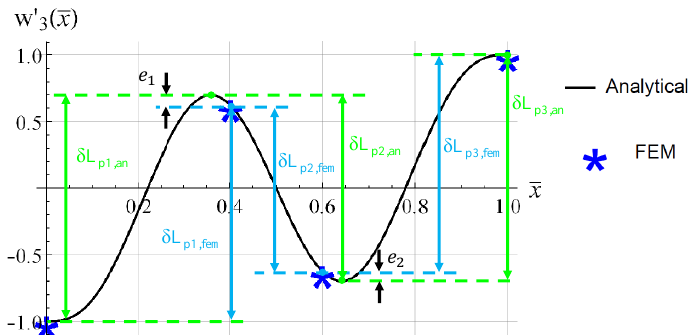
Figure 6. Example of discretization errors when evaluating the damping effectiveness in the case of free-free boundary conditions and third mode excitation. The total analytical virtual work δ L p , an = | δ L p 1, an | + | δ L p 2, an | + | δ L p 3, an | is the maximum theoretically achievable. Since 10 PZT actuator pairs are considered in the FEM simulations, the total virtual work, obtained via FEM, will be always lower than δ L p , an and it can be written as: δ L p , fem = | δ L p 1, fem | + | δ L p 2, fem | + | δ L p 3, fem | ≤ δ L p , an . e 1 and e 2 can be obtained as: e 1 = δ L p 1, an − δ L p 1, fem and e 2 = δ L p 3, an − δ L p 3, fem . It is worth noting that δ L p 2, an − δ L p 2, fem = e 1 + e 2 . The total percentage loss of damping due to the discretization L p , an − δ L p , fem = 2 e 1 + 2 e 2 = error (Equation (8)) is e ( % ) = δ δ L p , an δ L p , an